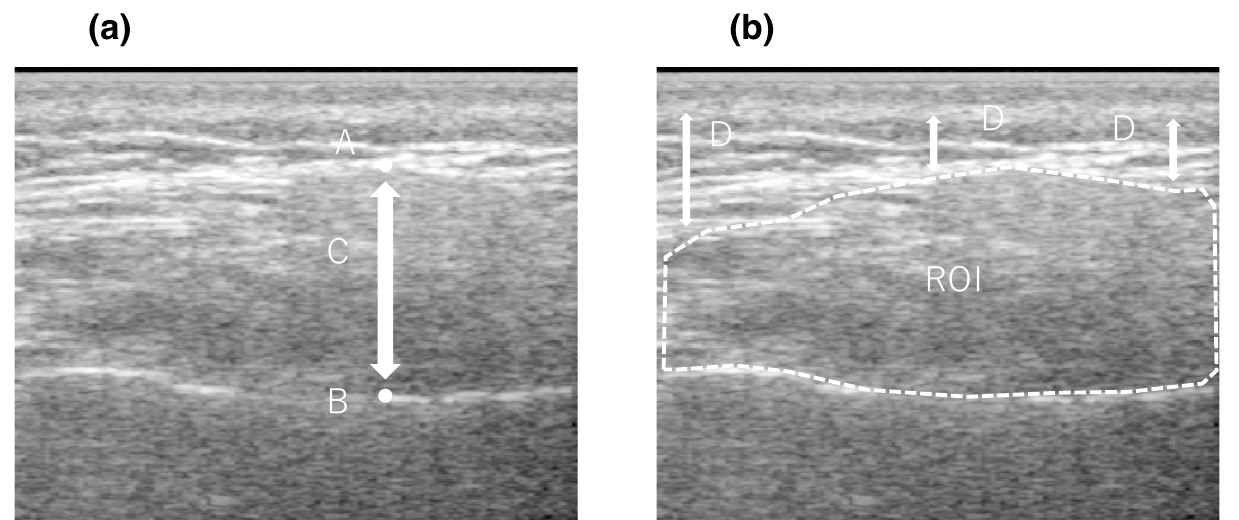
Figure 3. Masseter muscle evaluation by ultrasound diagnostic apparatus. (a) Masseter muscle thickness (MMT). (b) Masseter muscle echo intensity (MMEI) measurement. (A) Masseter muscle surface (B) Mandibular ramus (C) Masseter muscle thickness (D) subcutaneous fat thickness. ROI : region of